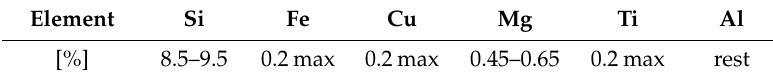
Figure 1. The metallographic microsections of the Al/SiC (10%). Table 1. The chemical composition Al/SiC composite.